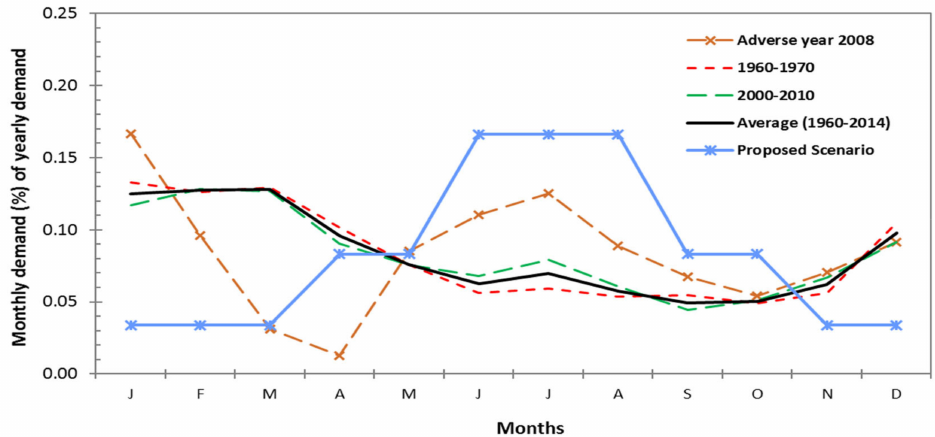
Figure 2. Monthly demands as percentages of yearly demands for characteristic year periods during the historic time series 1956–2014. In addition, a scenario for future management is proposed and shown in comparison to the average existing management and adverse year 2008 reservoir